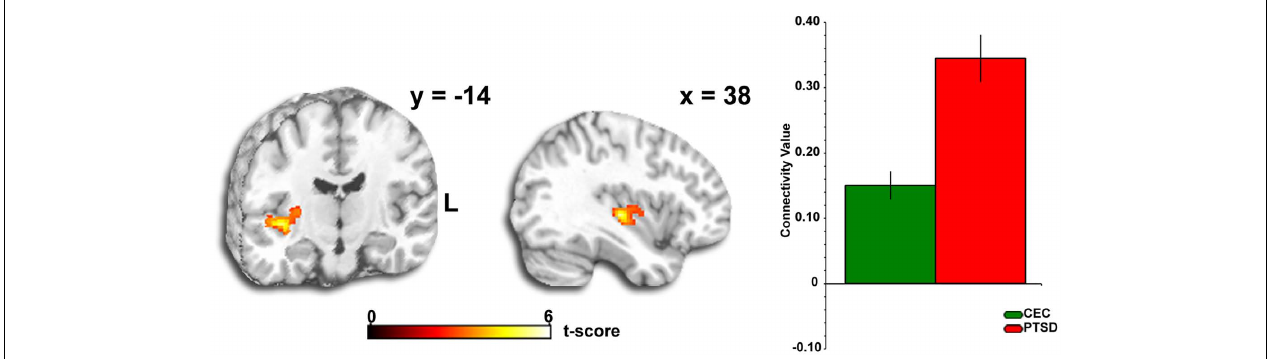
uncorrected; color bar represents statistical t -scores; Bar graph shows mean extracted Z- scores ( ± SEM) within each group from activated voxels that fell within an anatomically based insula mask, showing stronger connectivity in PTSD patients ( > CEC). PTSD, post-traumatic stress disorder; CEC, combat-exposed control; L,